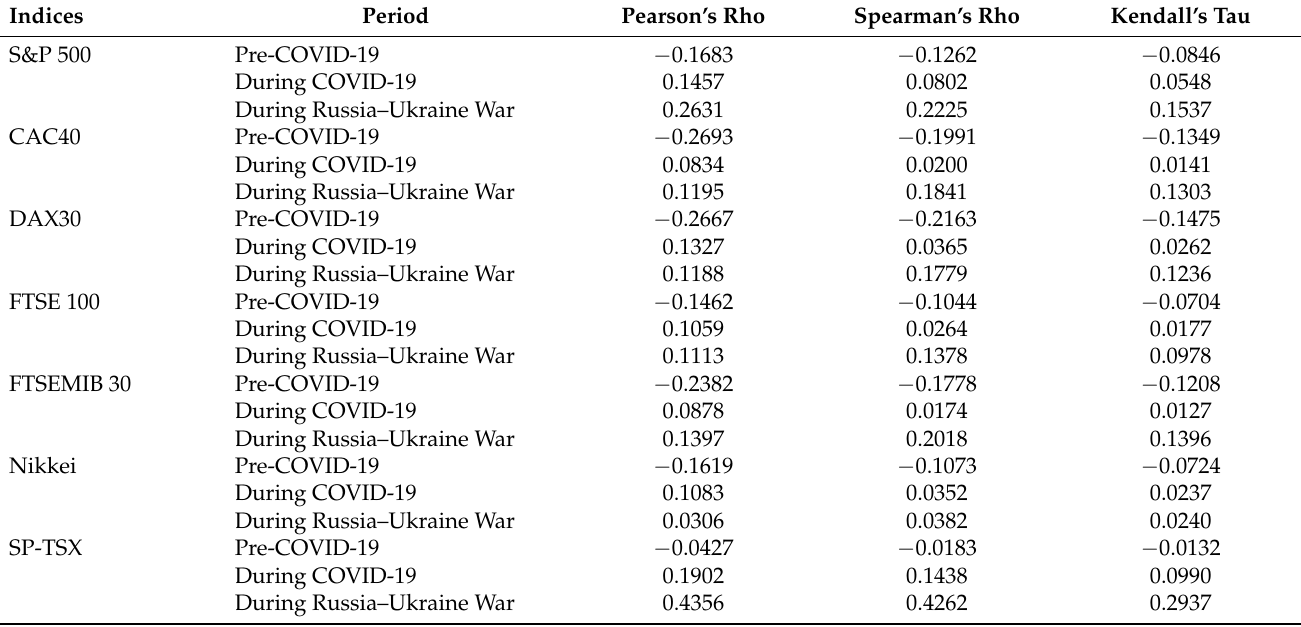
Table 3. Static Correlations for a Gold–G7 indices